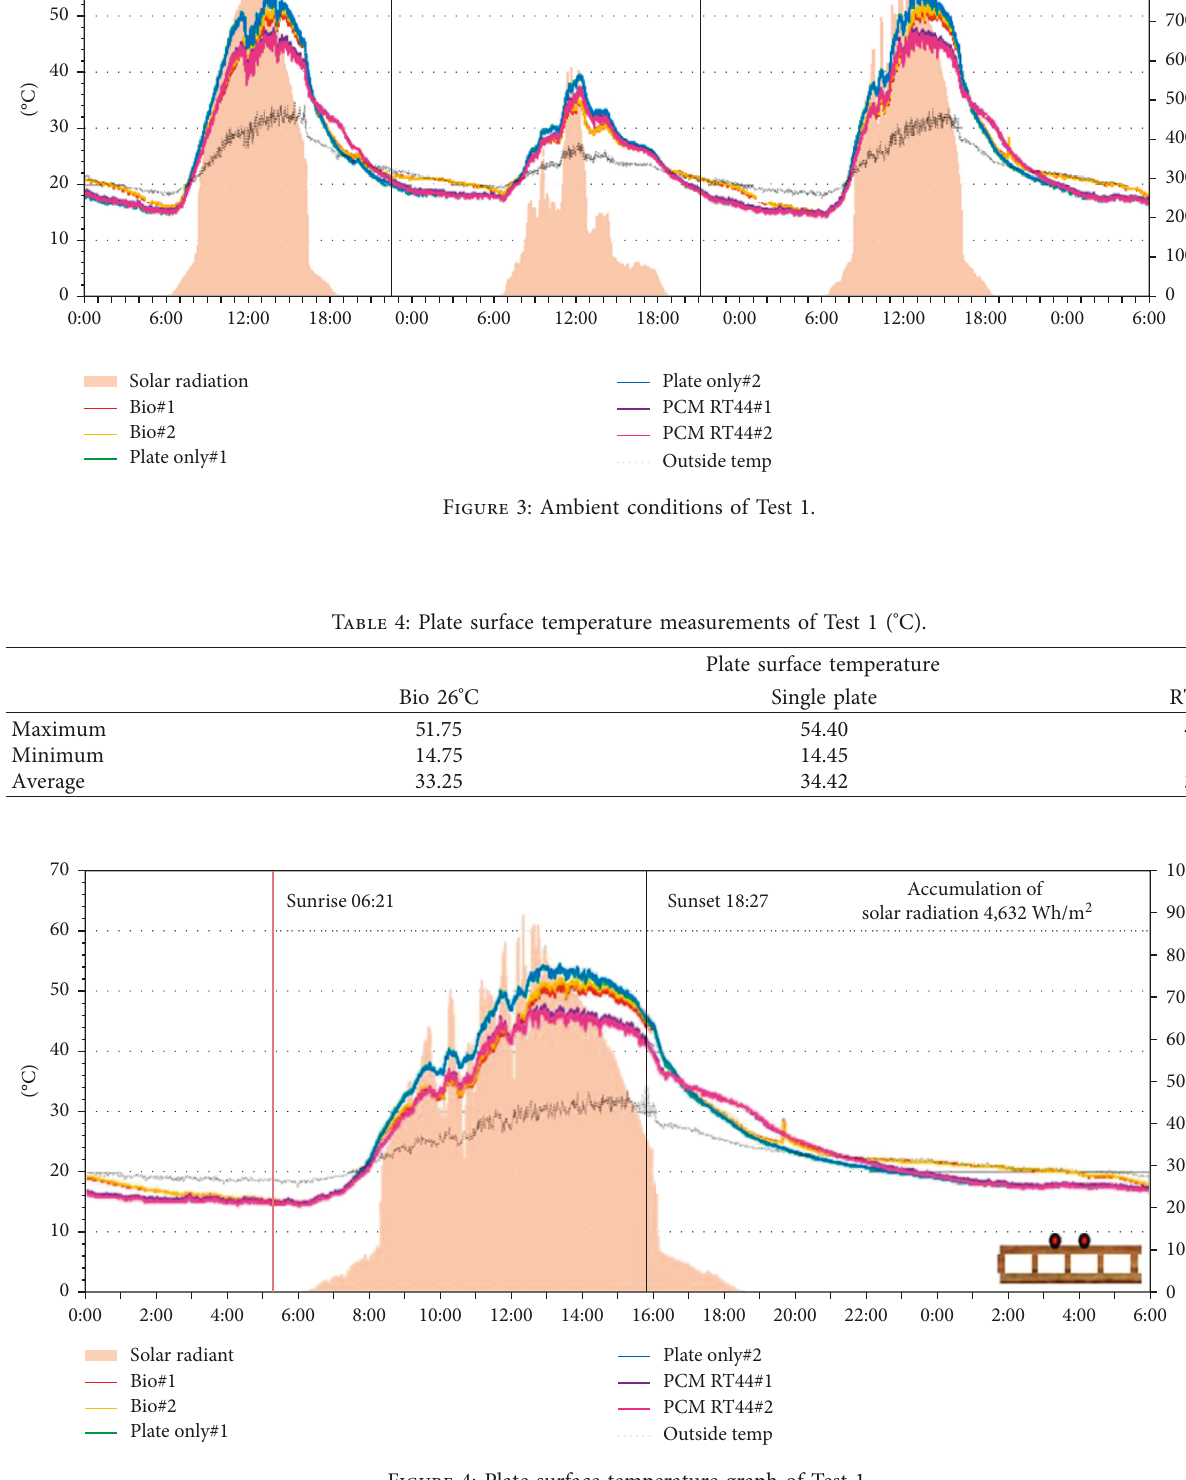
Figure 4: Plate surface temperature graph of Test